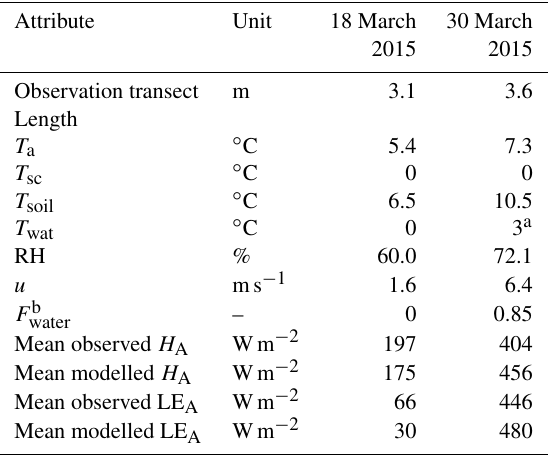
Table 3. Model parameters, estimates and observations for evalua- tion of the extended GM2002.